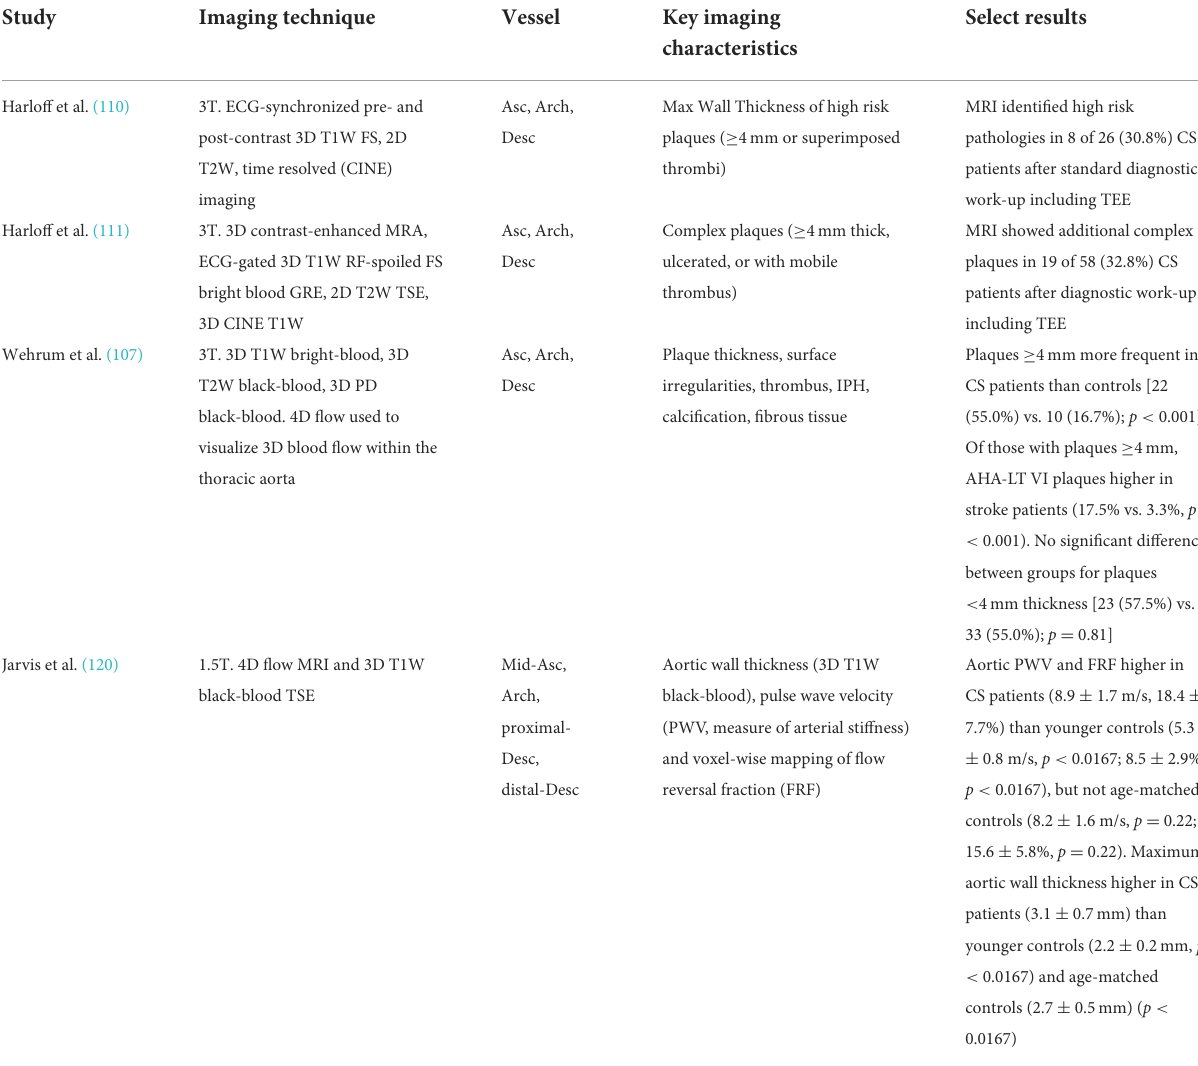
TABLE 5 Select studies using VW-MRI in an ESUS/CS population for evaluation of aortic arch